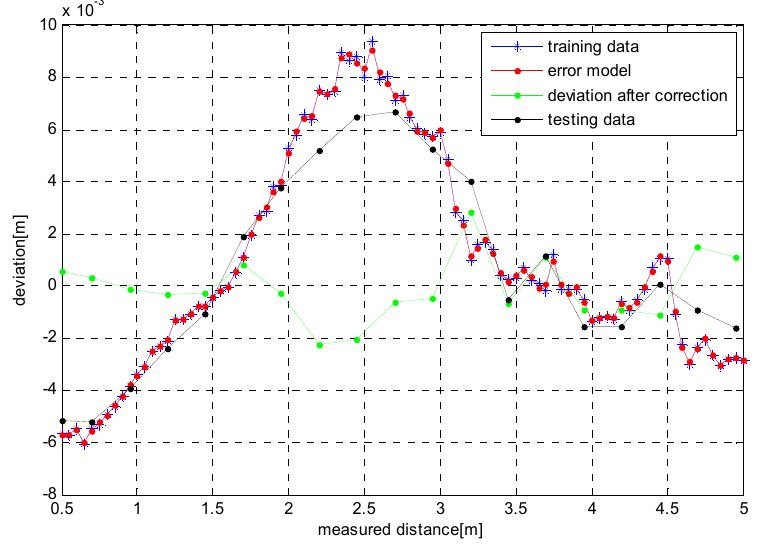
Figure 16. Depth error correction results and error model.